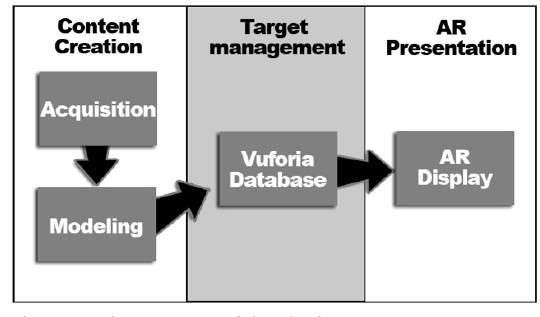
Figure 4. The structure of developing AR